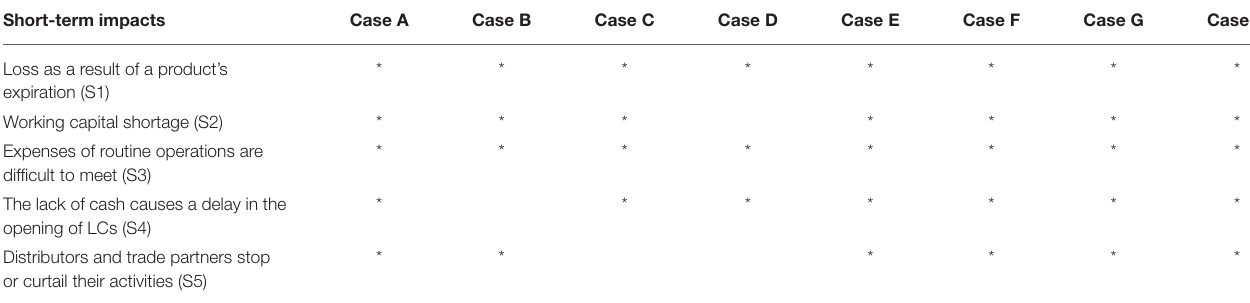
TABLE 2 | The short-term impact of the COVID-19 on the strategic emerging industries. Short-term impacts